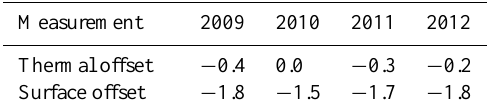
Table 9. Surface and thermal offsets (in ◦ C) for each year of the study period.